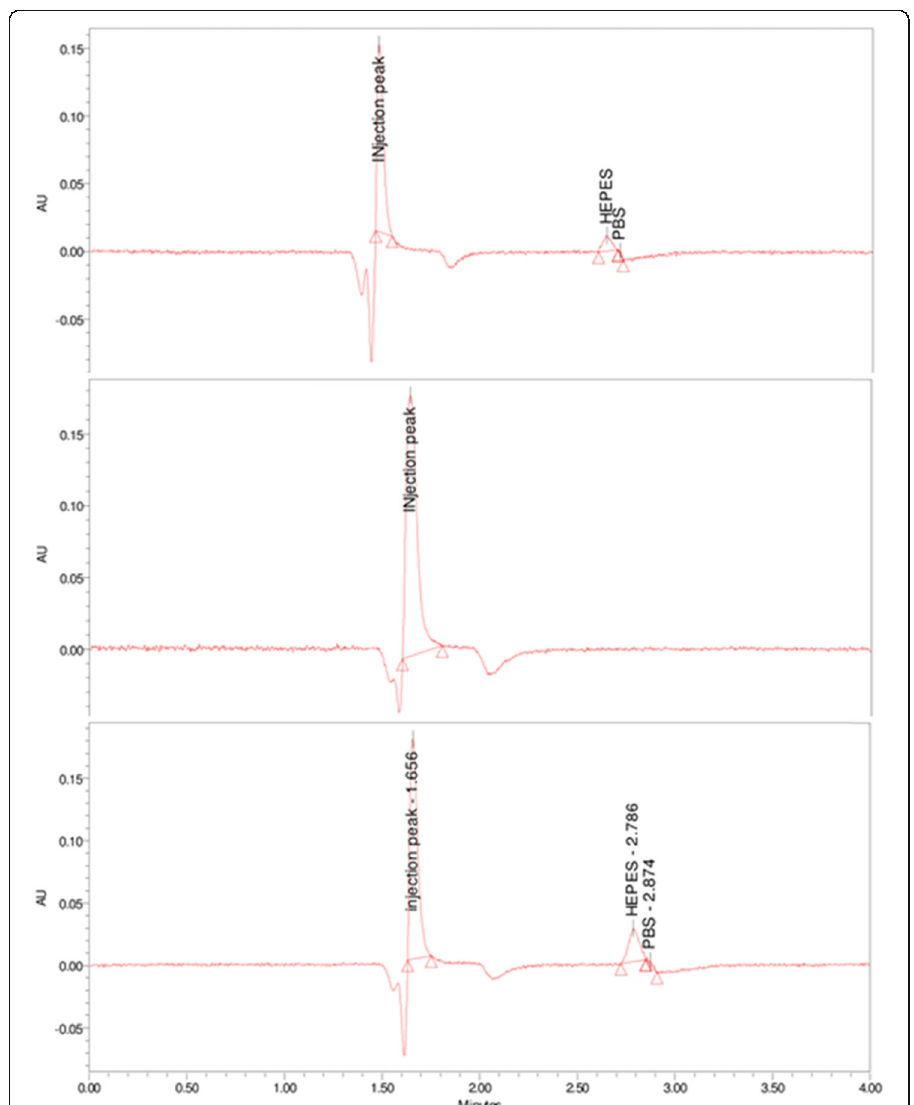
Fig. 2 Examples of chromatograms with an isocratic system of NH 4 HCO 2 20mM pH 9.5, UV 195nm, from 0 to 4min of: an HEPES solution (top); a GA-DOTATOC (middle) solution and a [ 68 Ga] GaDOTATOC solution